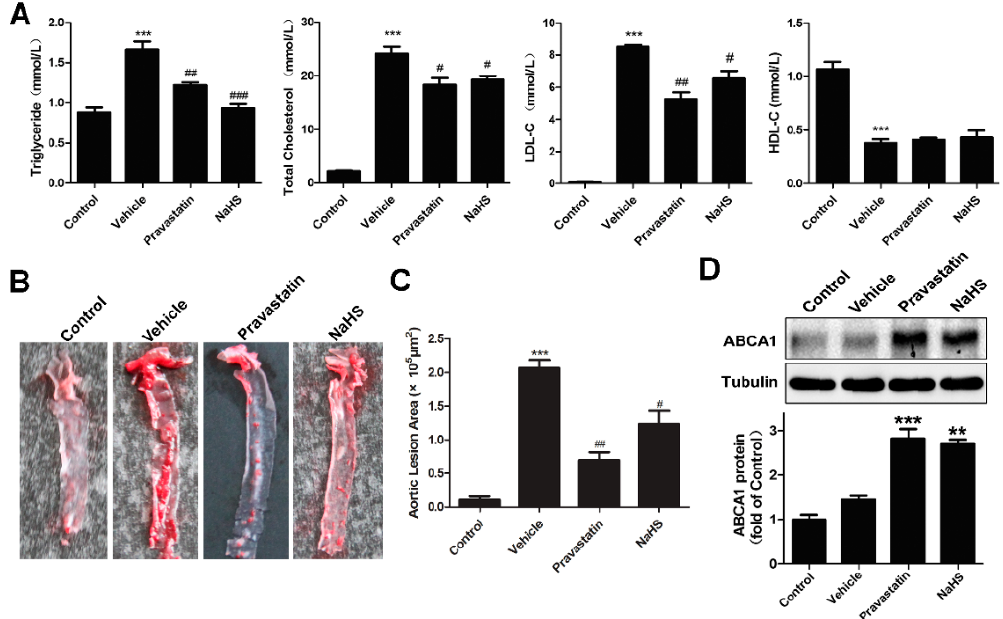
Figure 3. Effects of NaHS on the lipid metabolism of high-fat dieted ApoE − / − mice. Six-week-old ApoE − / − mice fed a high-cholesterol diet were dosed daily with NaHS (50 μ M/kg/day, intraperitoneally), pravastatin (30 mg/kg/day, intragastrically), or vehicle (saline solution) for 14 weeks. ( A ) Serum was reserved for detecting total cholesterol (TC), triglycerides (TG), low-density lipoprotein cholesterol (LDL-C) and high-density lipoprotein cholesterol (HDL-C, n = 10, *** p < 0.001 vs. control; # p < 0.05, ## p < 0.01, ### p < 0.001 vs. vehicle); ( B ) Representative images of Oil Red O-stained aortas; ( C ) Quantization of lesion areas in Oil Red O-stained aortas ( n = 10, *** p < 0.001 vs. control; # p < 0.05, ## p < 0.01 vs. vehicle); ( D ) Livers were collected from each group. Equal amount of proteins from liver lysates of each mouse in the same group were pooled and subjected to Western blotting for ABCA1 expression. Tubulin was used as a control ( n = 10, ** p < 0.01, *** p < 0.001 vs.